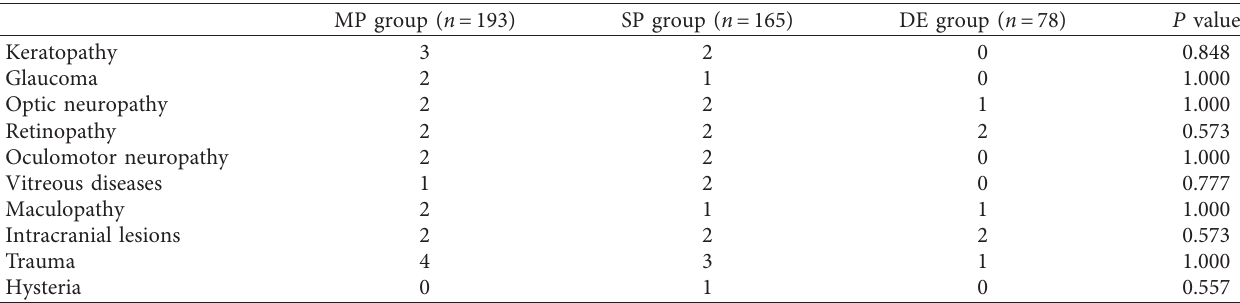
Table 3: Comparison of the causes of visual dysfunction in each group (Fisher exact probability method).